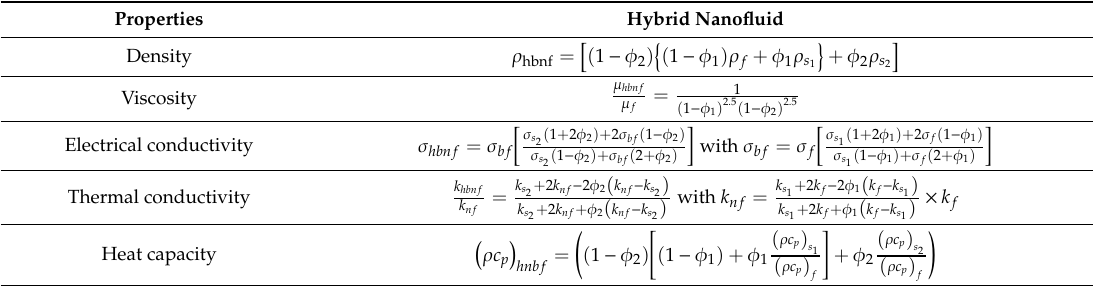
Table 1. The thermophysical attributes of the hybrid